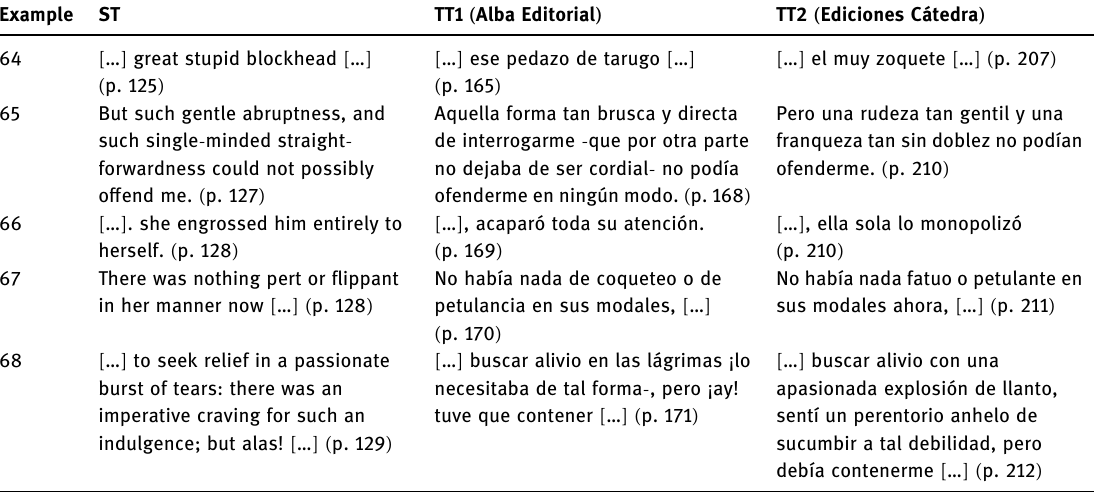
Table 13: Examples taken from Chapter 15 Example